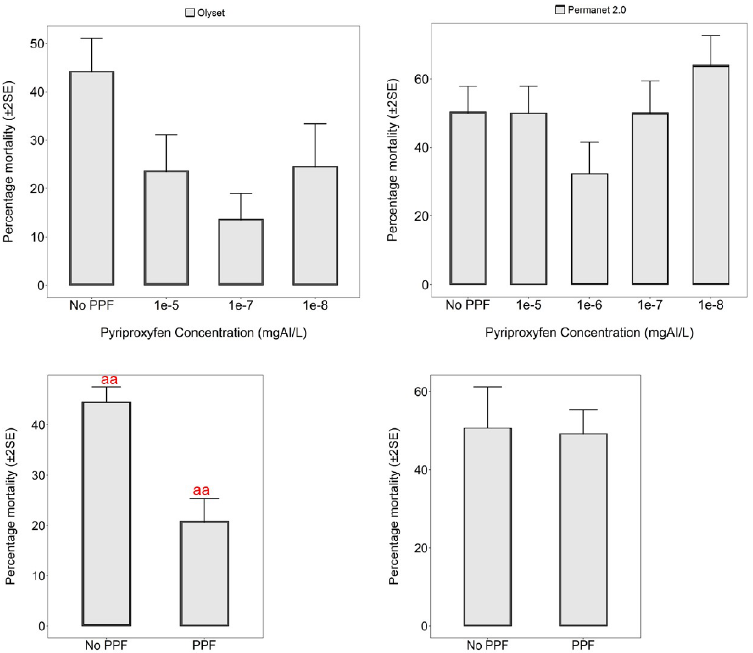
Fig 5. Bio-efficacy (% 24-hr mortality) in cone bioassays of WHO-recommended Olyset 1 Net against colony- derived pyrethroid-resistant An . arabiensis mosquitoes, collected as 3 rd instar larvae and reared through different doses of PPF. “No PPF” represents % mortality of mosquitoes from the same colony, which was not treated with PPF but was exposed to the same net. aa Letters show significant difference when resistant Anopheles arabiensis colony pre- exposed to PPF and those without pre-exposure are exposed to Olyset Net, p < 0.001.